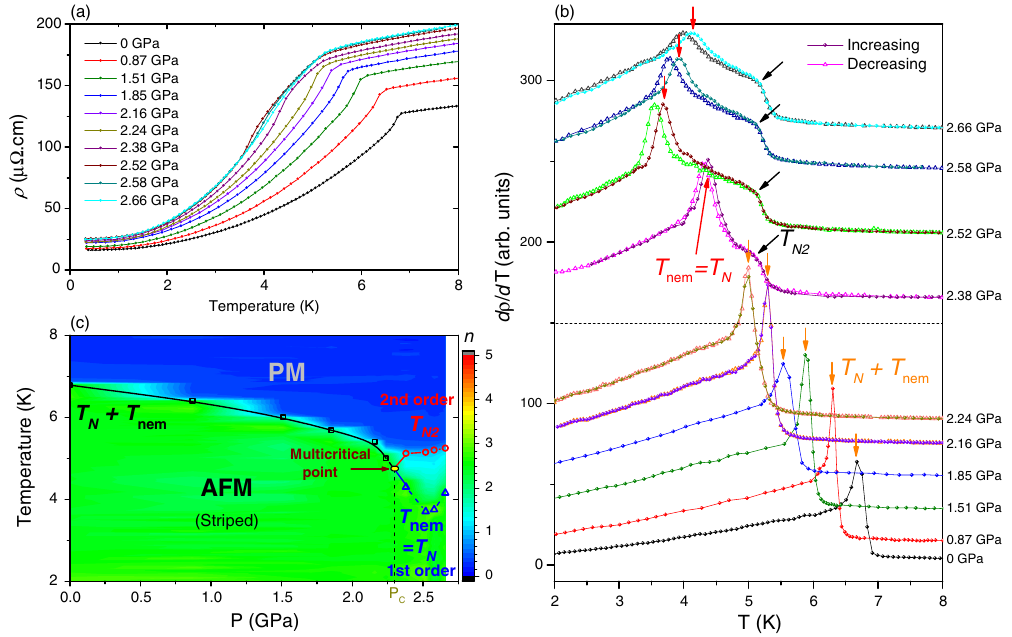
FIG. 3. (a) Temperature dependence of the in-plane electrical resistivity, ρ derivative of ρ under pressure. Data at different pressures are shifted for clarity. Arrows indicate peak positions: orange, black, and red ab þ T ¼ T arrows for T , T , and T , respectively. Above 2.16 GPa, the results from increasing- and decreasing-temperature N N 2 N nem nem ramps are indicated by solid and open symbols, respectively. (c) T - P phase diagram of CeAuSb 2 in zero applied field. Colors represent the local exponent, n ¼ ∂ ln Δ ρ = ∂ ln T